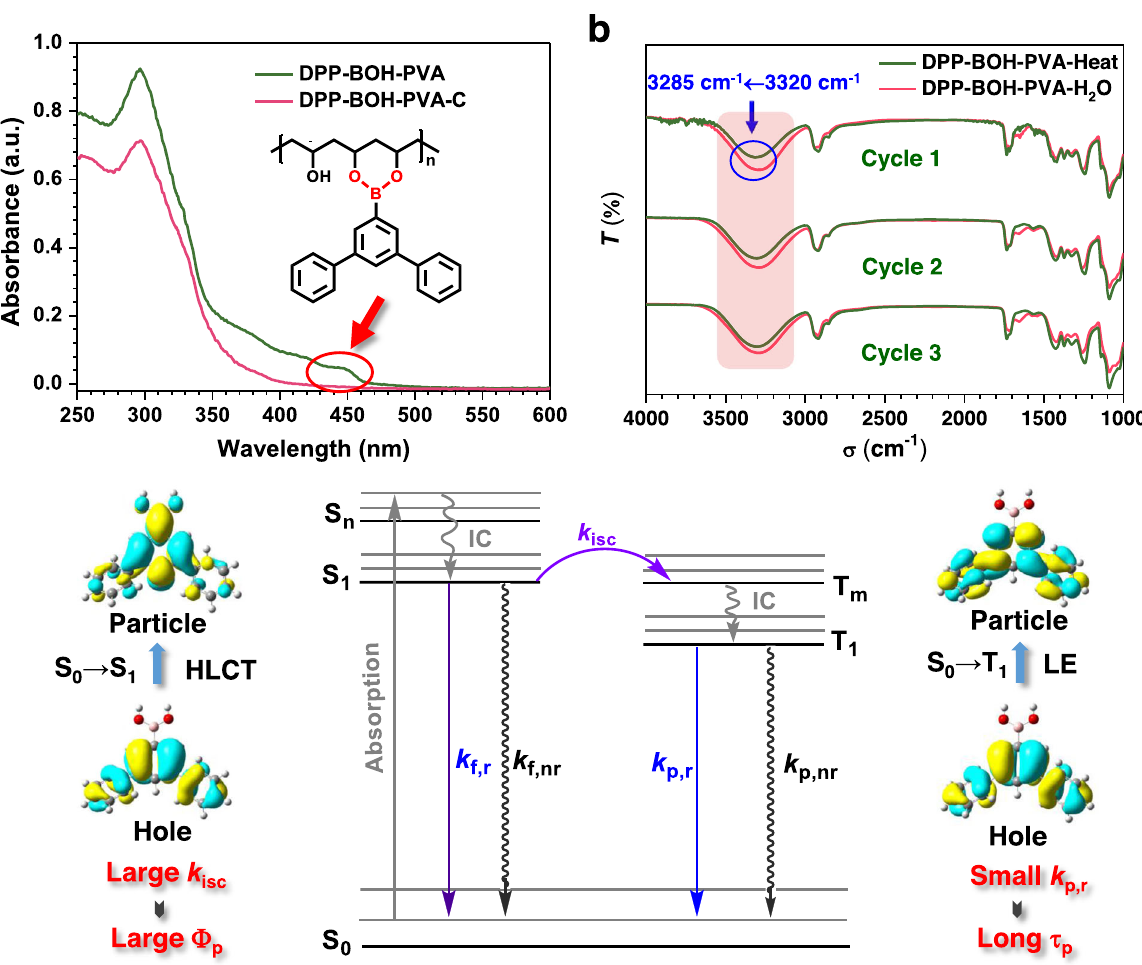
Fig. 3 The mechanism for ultralong phosphorescence of DPP-BOH-PVA fi lm. a The absorption spectra of DPP-BOH-PVA fi lm and DPP-BOH-PVA-C fi lm, and the chemical structure of DPP-BOH-PVA. b Three repeated cycles for the Fourier transform infrared (FTIR) spectra of DPP-BOH-PVA fi lm under of the heating/water stimuli. c The Jablonski diagram and theoretical calculations about natural transition orbitals (NTOs) for DPP-BOH (HLCT = hybridized local and charge transfer, LE = locally excited, IC = internal conversion, k isc = rate constant of intersystem crossing, k p,r = radiative rate constant of phosphorescence, Φ p = phosphorescence quantum yield, τ p = phosphorescence